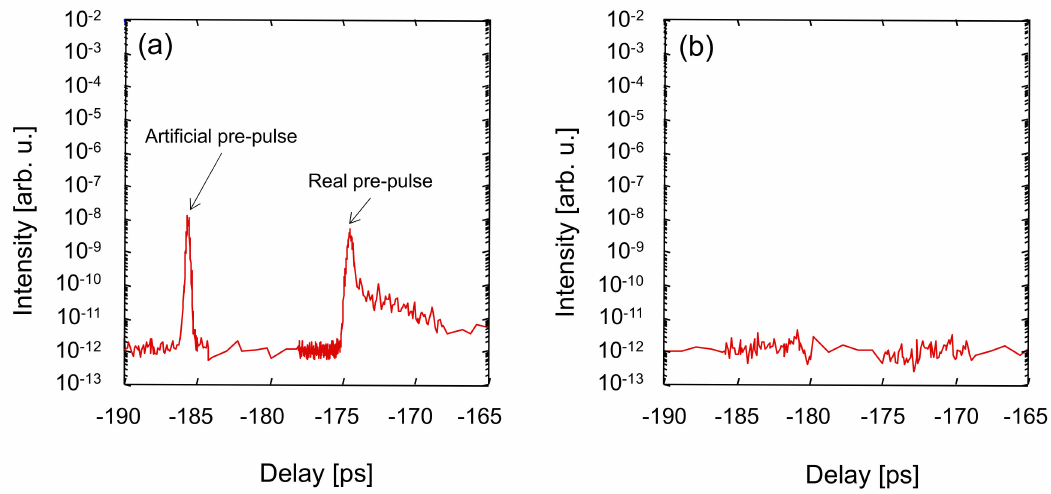
Figure 13. Representative measured pre-pulses in the J-KAREN-P laser system by the Ti:sapphire pre-amplifier crystal with ( a ) no wedge and ( b ) a small wedge angle.